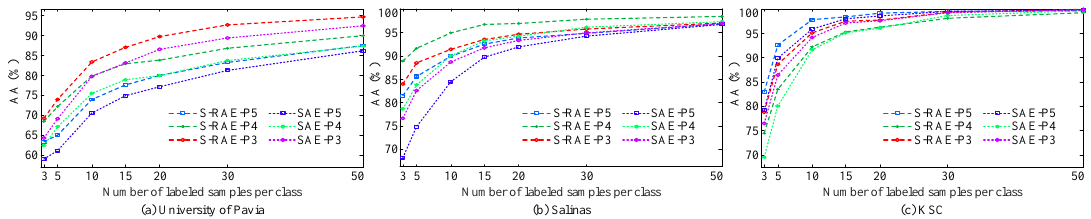
Figure 7. Comparison of classification results from deep spatial feature preprocessed by SAE and S-RAE on datasets of ( a ) University of Pavia, ( b ) Salinas, and ( c ) KSC.